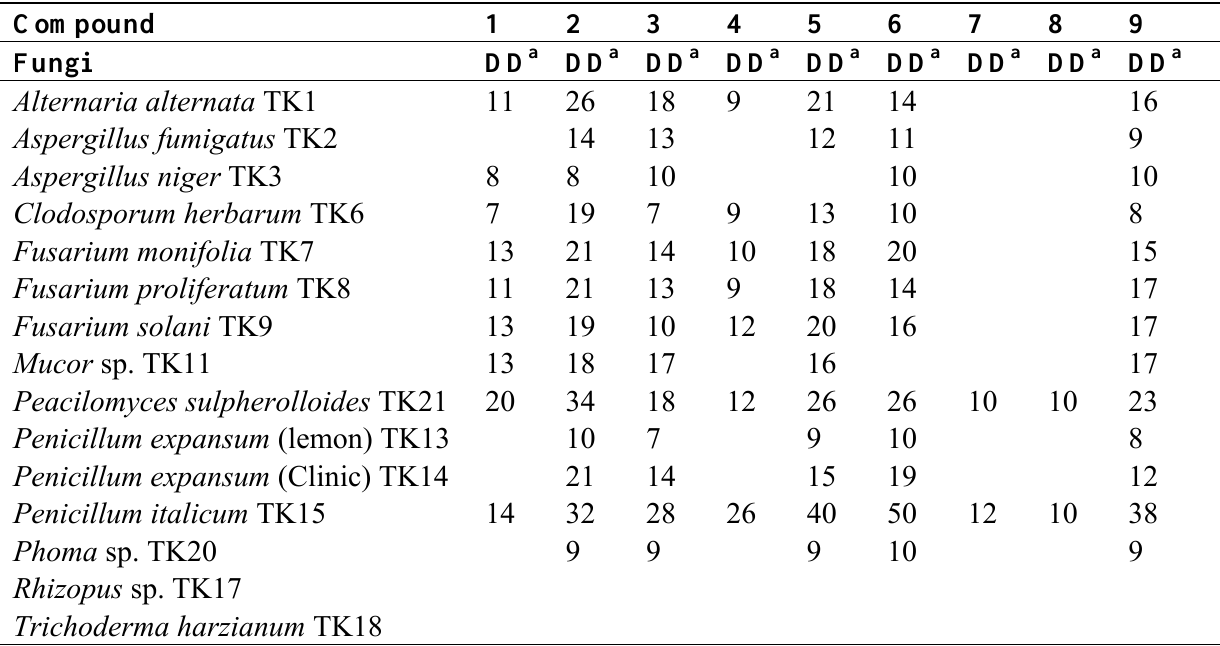
Table 3. Antifungal activity of synthesized compounds against fungi isolates. The test was based on disk diffusion method.